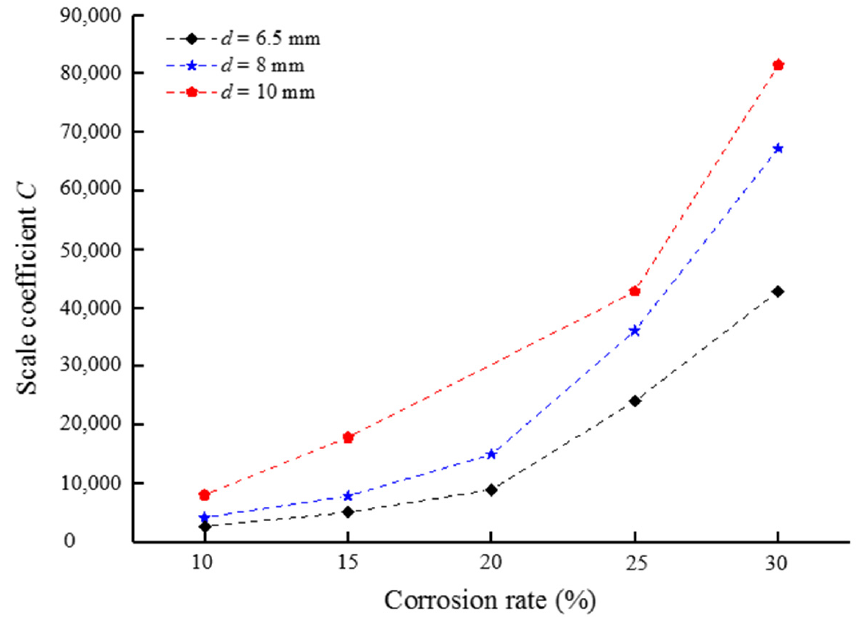
Figure 9. Relationship between corrosion rate and scale coefficient.